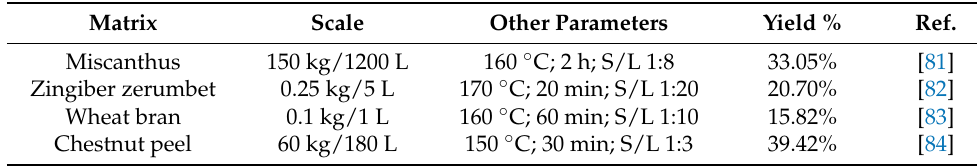
Table 3. Studies on pilot scale SWE, from 2017 to 2022.